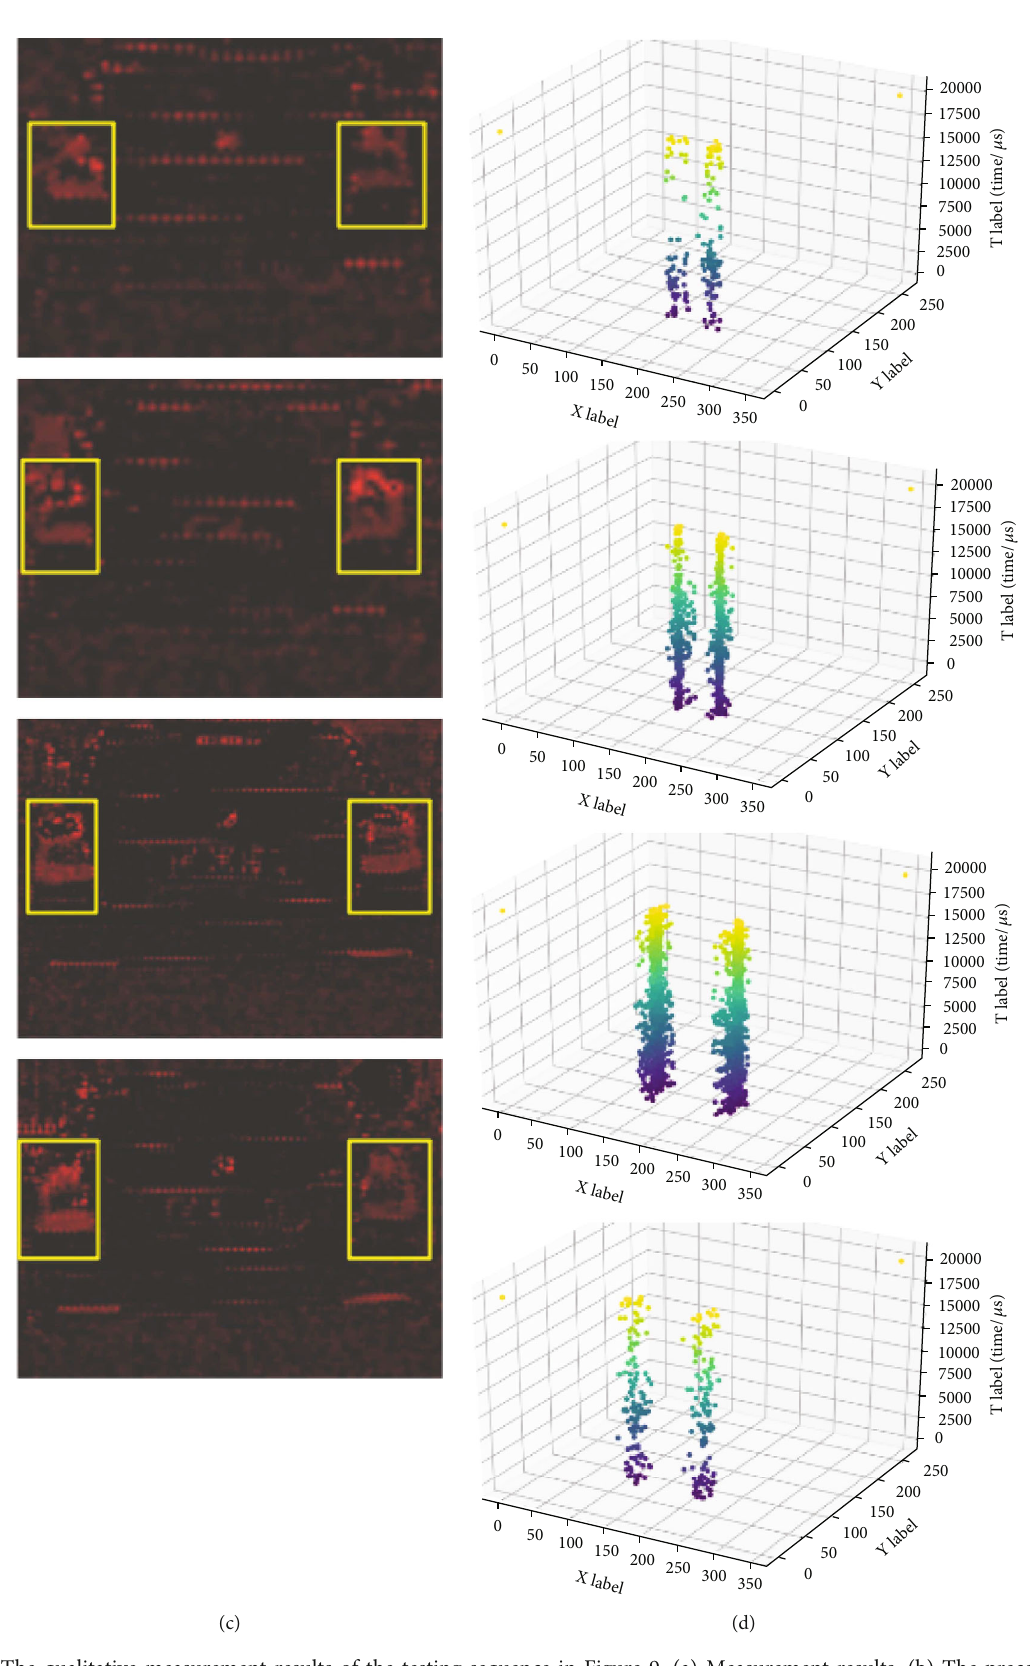
Figure 10: The qualitative measurement results of the testing sequence in Figure 9. (a) Measurement results. (b) The preceding vehicle detected. (c) The position of the vehicle ’ s taillights located. (d) DVS events for each taillight